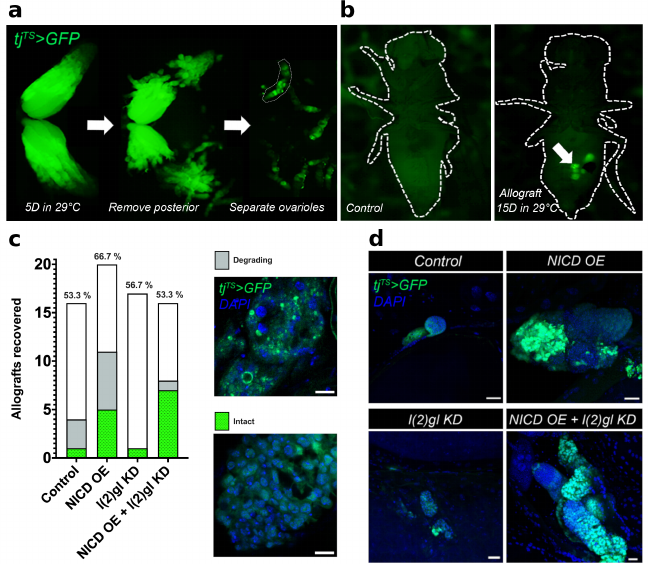
Figure 2. Cells with ectopic NICD expression gain a long-term survival advantage. ( a ) Fluorescent image from a dissecting microscope showing the steps for allograft preparation. First, Gal4 activity was initiated by transferring three-day-old female flies to permissive temperature (29 ◦ C) for five days. Ovaries with follicle cell tj TS > GFP marker (green) were dissected (left), cut to remove the bulky posterior half of the ovaries including and following stage 10A (middle), and ovarioles were gently teased apart (right) for implantation into the host fly. ( b ) Fluorescent image of a host flies following implantation of NICD OE + l(2)gl KD tumor tissue (right) next to an uninjected control (left) following 15 days in 29 ◦ C. GFP-expressing (tj TS > GFP) allograft tissue (green) was visible through the abdomen of the host fly (arrow). ( c ) Bar graph showing numbers of surviving flies. Within each bar, the number of flies which had GFP + allograft tissue is shown in green and gray. Green bars represent allograft tissue that was intact, characterized as having entire nuclei and cytoplasmic GFP expression. Gray bars represent degrading allograft tissue characterized by bright, punctate GFP and DAPI signal. ( d ) Confocal images of an intact allograft tissue from each genotype after 15 days in 29 ◦ C. DAPI marks nuclei. Scale bar = 20 µ